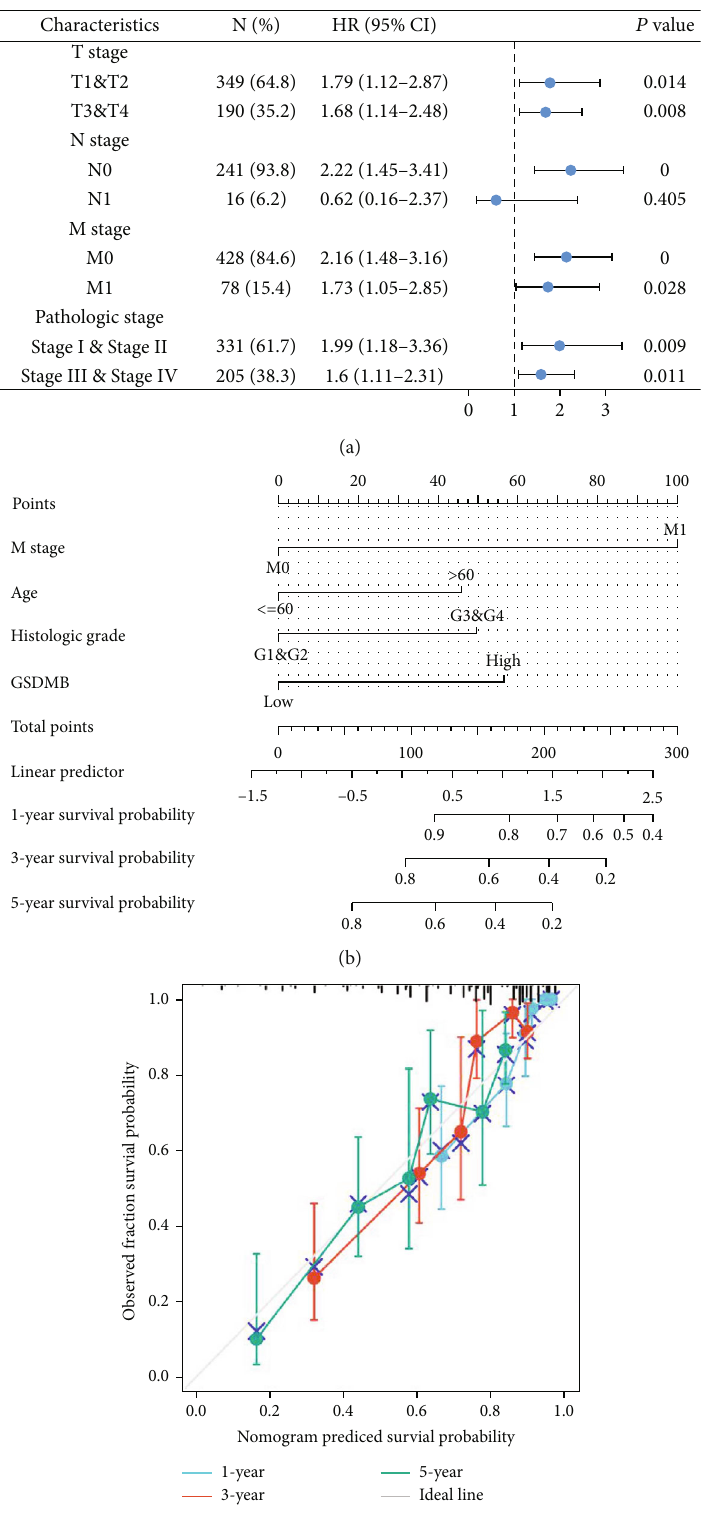
Figure 5: (a) Multivariate survival analysis of overall survival probabilities concerning GSDMB expression in patients with di ff erent subgroups according to the cancer stage. (b) Nomogram for predicting the probability of 1-, 3-, and 5-year OS for ccRCC patients. (c) Calibration plot of the nomogram for predicting the OS likelihood. ccRCC: clear cell renal cell carcinoma; OS: overall